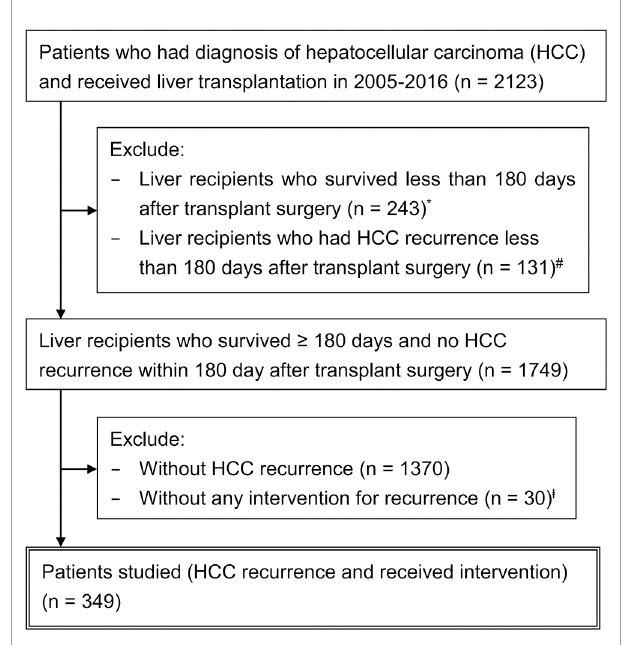
FIGURE 1 | Schematic representation of the patient selection process. *Contained patients with HCC recurrence deemed un fi t or too advanced for any treatment. #Within 6 months after transplant surgery, 41 (31.3%) patients had complications (rejection, surgical complication, or sepsis) and 21 (16.0%) expired. The initial interventions included radiotherapy (n = 37), chemotherapy (n = 35), sorafenib (n = 26), transarterial chemoembolization (n = 25), and others (n = 8). However, 33 patients (25.2%) survived unusually longer than 5 years, suggesting data miscoding or adjuvant treatments, rather than true recurrence. ╪ 14 (46.7%) patients had complications within 6 months after transplant surgery. Sixteen patients (53.3%) survived unusually longer than 5 years without any oncological interventions, suggesting another area of miscoding and data contamination. These patients (# and ╪ ) were excluded from the main cohort for analysis because their data were highly heterogeneous and lack of con fi dence, and validated discrimination between true recurrence and false positivity was not